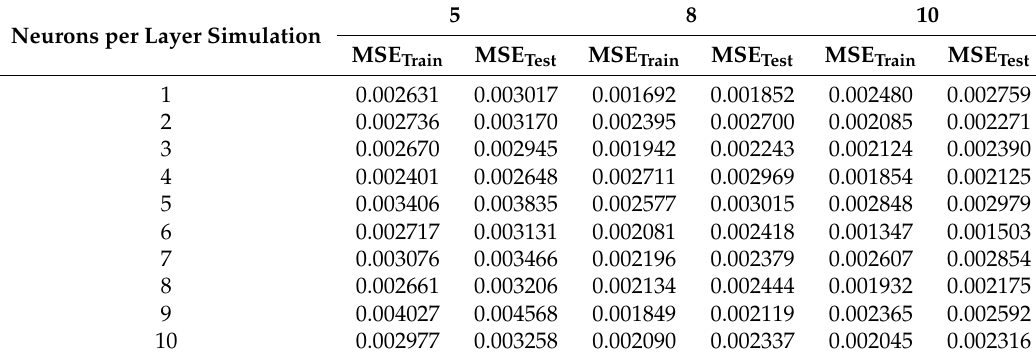
Table 3. Mean Squared Error of the Coupled Tanks Liquid Level model for several modeling approaches of with a different number of neurons and with two hidden